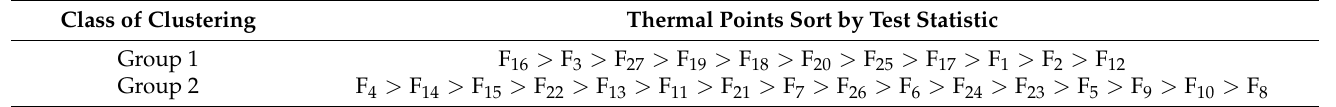
Table 3. The analysis result of optimization algorithm for the second machine tool. Class of Clustering Thermal Points Sort by Test Statistic